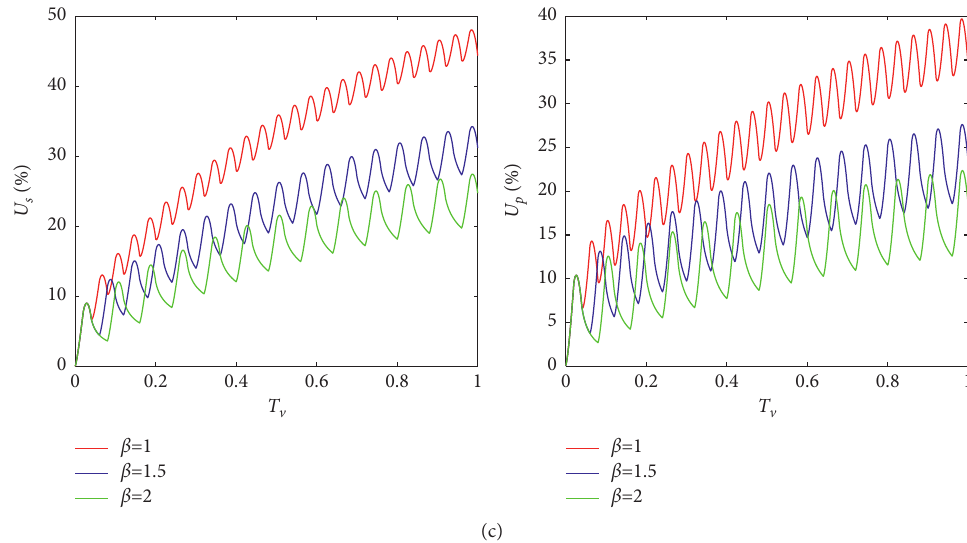
Figure 14: The variations of average degrees of consolidation U